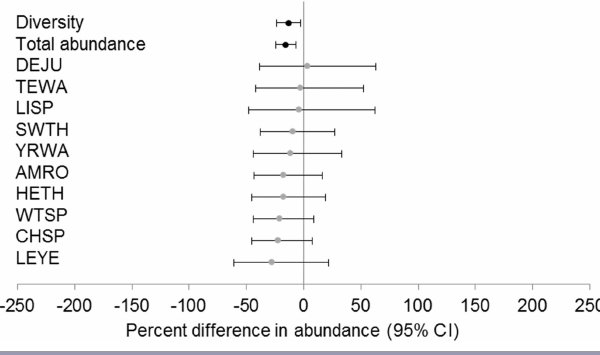
Fig. 5 . Percent difference (95% confidence interval [CI]) in relative abundance in counts from on-road autonomous recording unit (ARU) North American Breeding Bird Survey (BBS) and forest-edge ARU BBS surveys. Values lower than 0 indicate higher counts in on-road ARU BBS surveys, whereas values higher than 0 indicate higher counts for the forest-edge ARU BBS survey. Black circles indicate statistically significant differences. See Results for definitions of